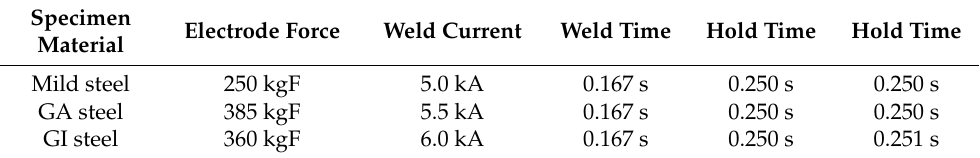
Figure 5. Cross-section test images of the welded specimen: ( a ) normal state, ( b ) small nugget. Table 2. Weld conditions for each